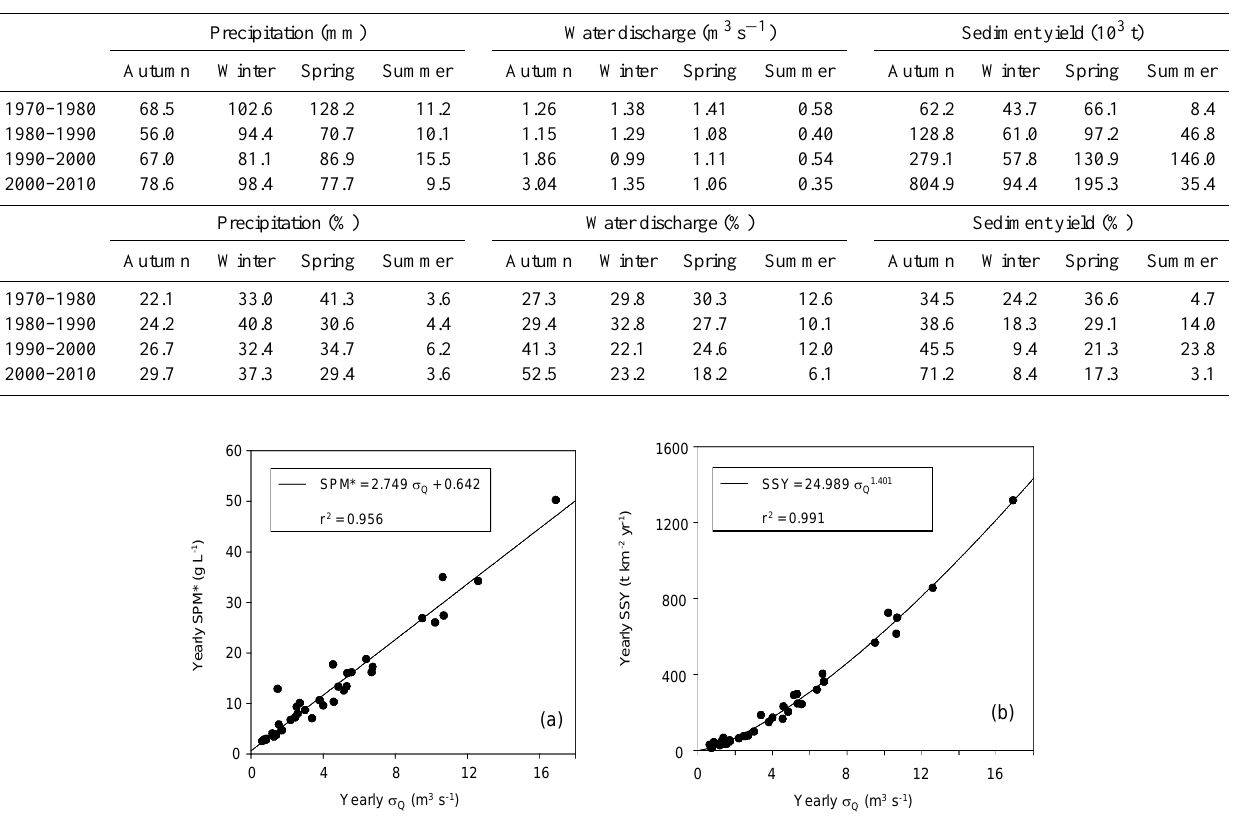
Figure 10. Yearly average of related sediment load parameters vs. intra-annual variability of daily river discharge, characterized by their annual standard deviation. (a) displays SPM ∗ , (b) specific sediment